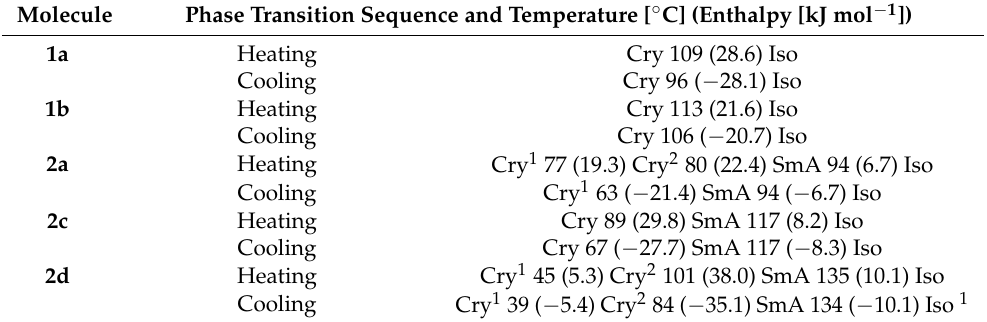
Table 2. Phase transition sequences and temperatures during the second heating and cooling pro- cesses 1